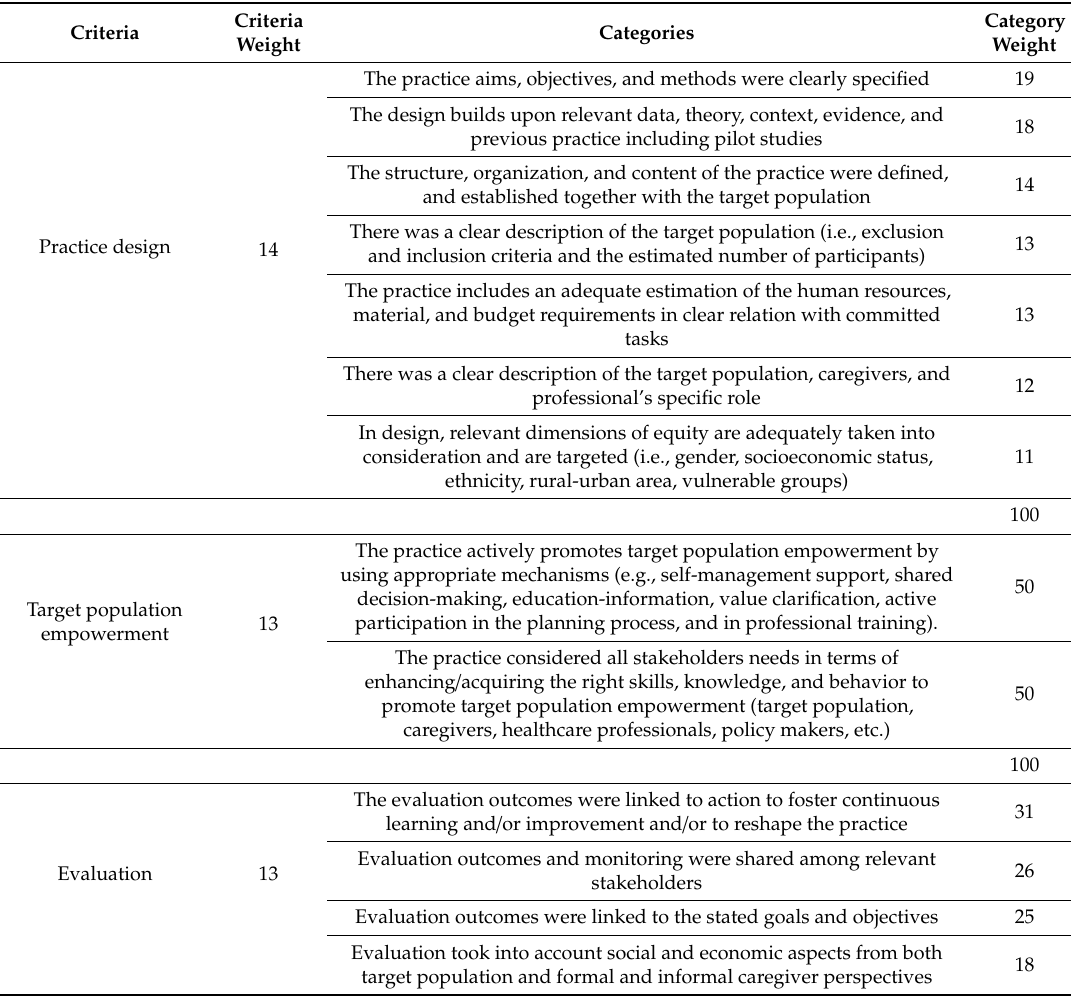
Table 1. Joint action in chronic diseases (JA CHRODIS), quality criteria, defined and ranked by RAND-modified DELPHI